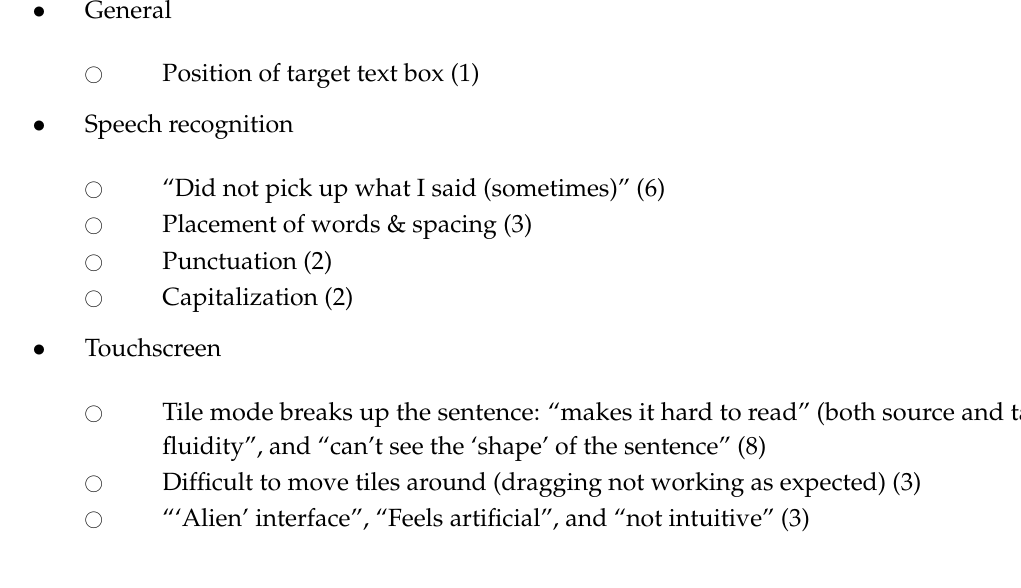
Figure 11. Preferred interaction modes as indicated by participants.